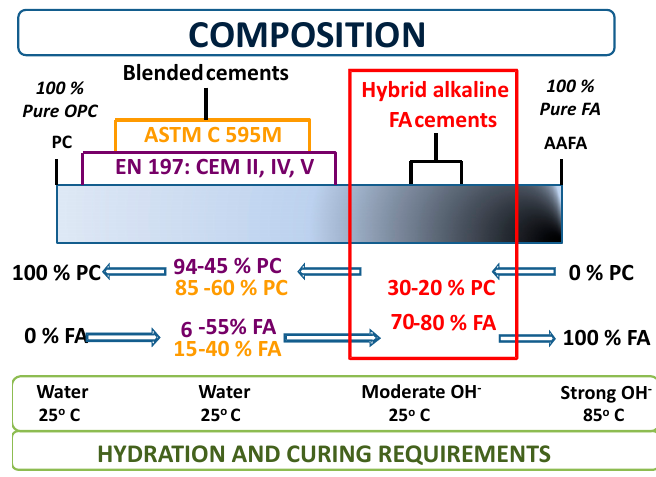
Figure 1. Position of hybrid alkaline fly ash cements on the pure Portland cement (PC)-pure alkali activation of fly ash (AAFA) spectrum, relative to pozzolanic fly ash cements.